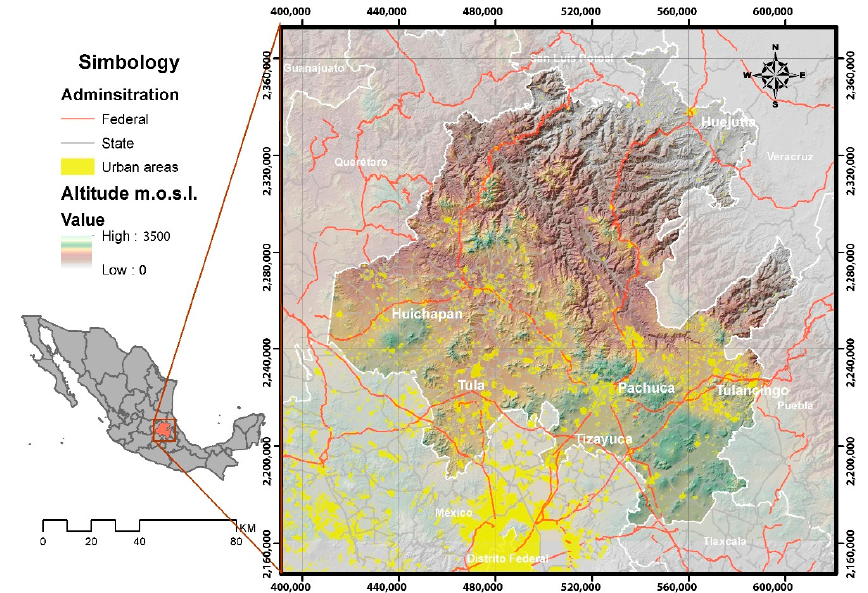
Figure 1. Location of the state of Hidalgo in Central Mexico.